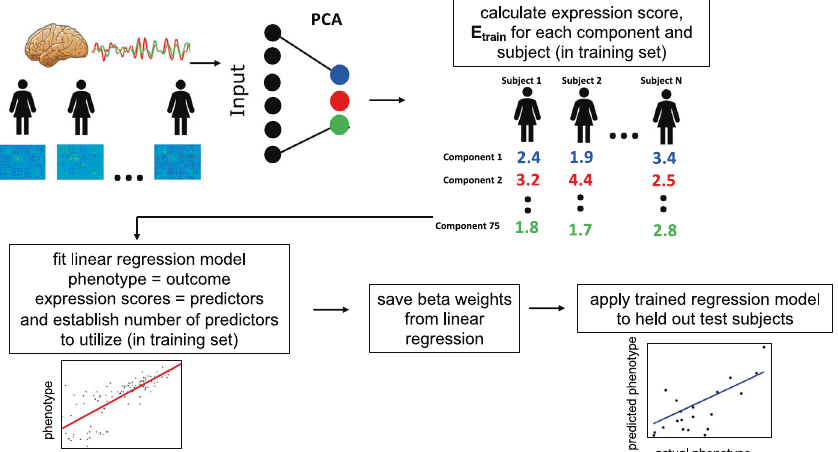
Fig. 1 Steps of Principal Component Regression Predictive Modeling. Brain connectivity features enter data reduction yielding a smaller set of brain components. A linear regression model is fi t with brain component expression scores predicting a phenotype. The components as well as betas from the linear regression are then applied out of-sample to test data to generate predicted scores and evaluate